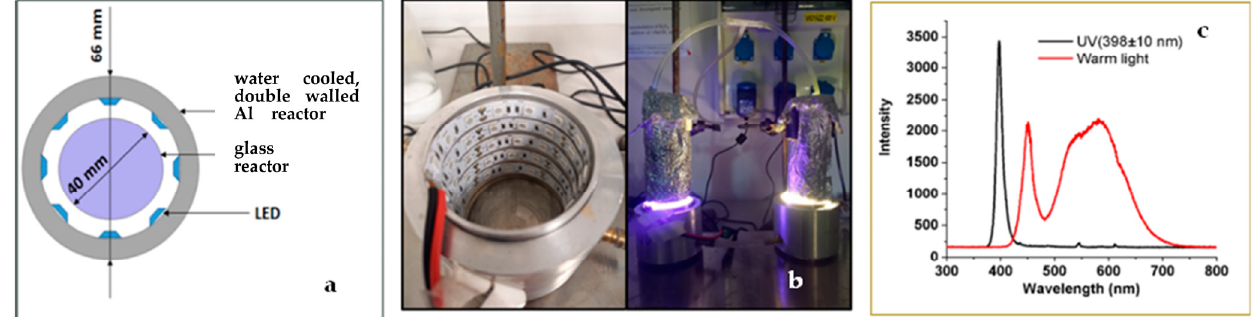
Figure 11. The schematic figure ( a ) and photo ( b ) of the reactors and the emission spectra of the LED light sources ( c ).